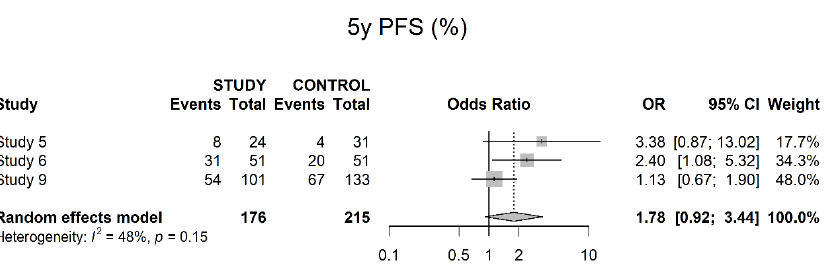
Figure 14. Five-year progression-free survival.